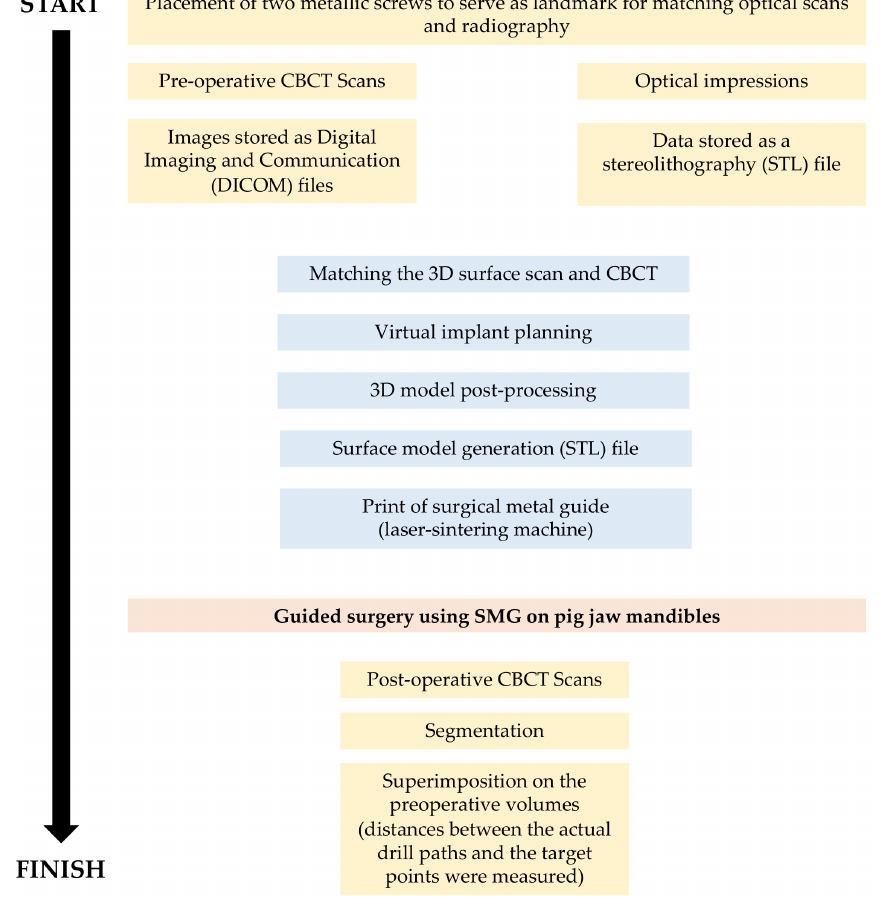
Figure 1. Workflow diagram of the study design.